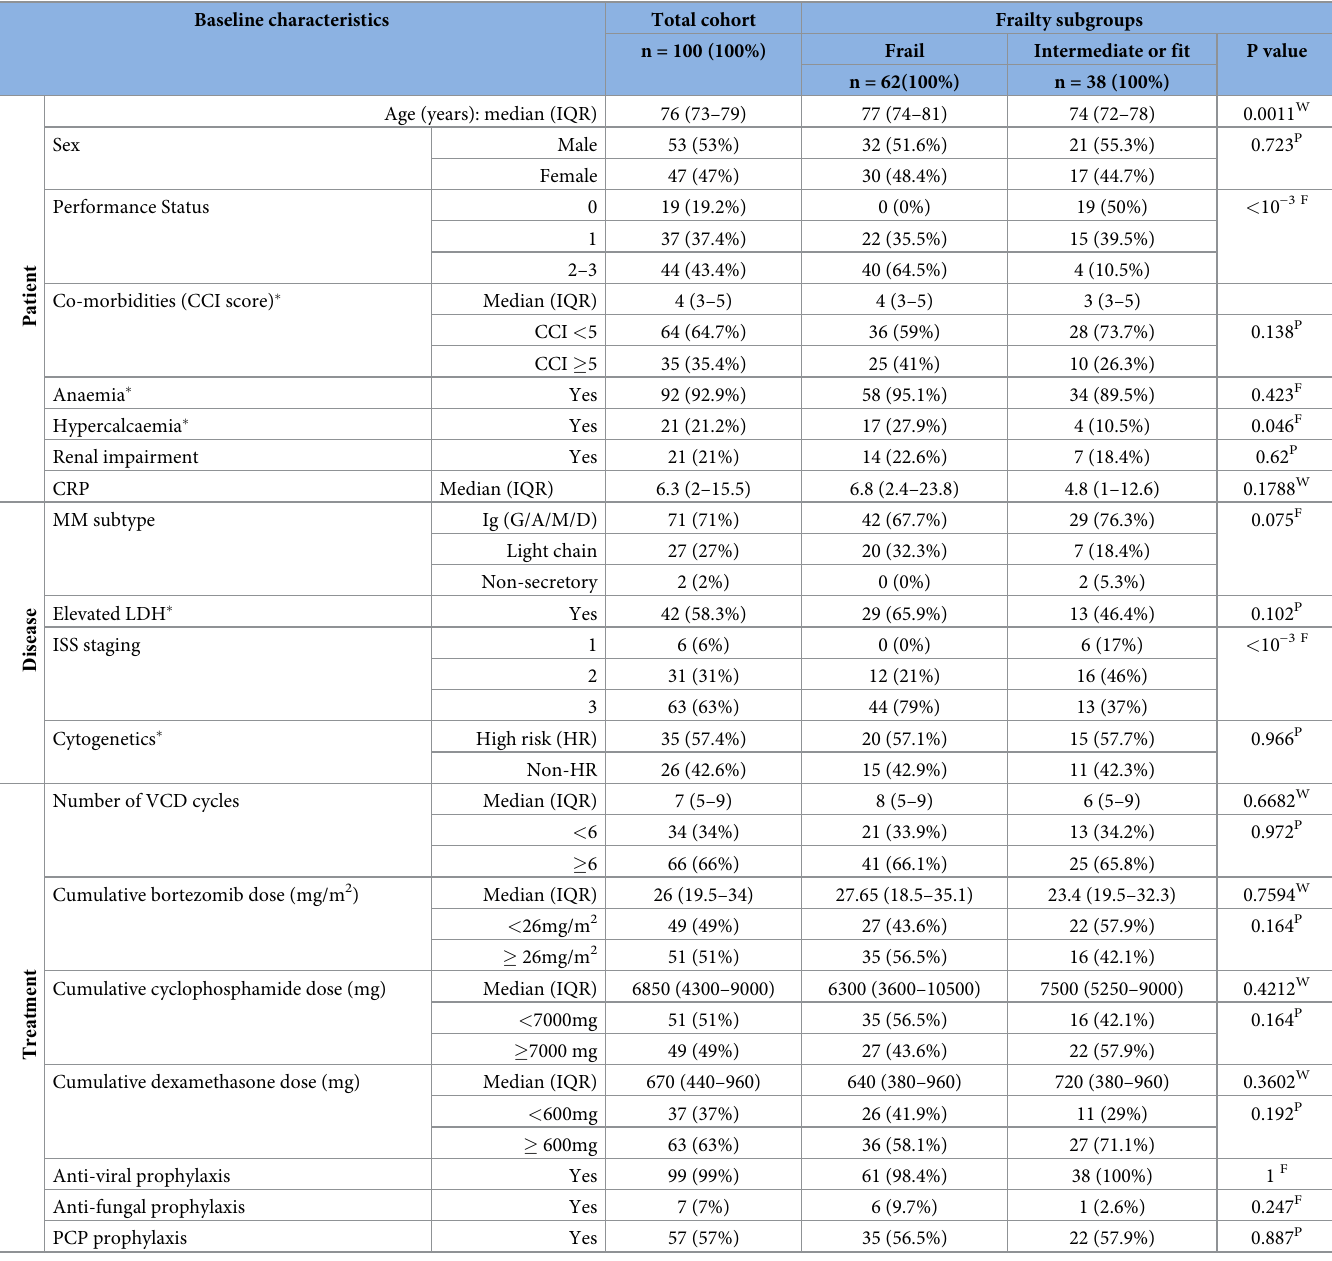
Table 1. Baseline patient, disease and treatment characteristics for the total cohort, and for the different MRP subgroups (frail vs. intermediate or